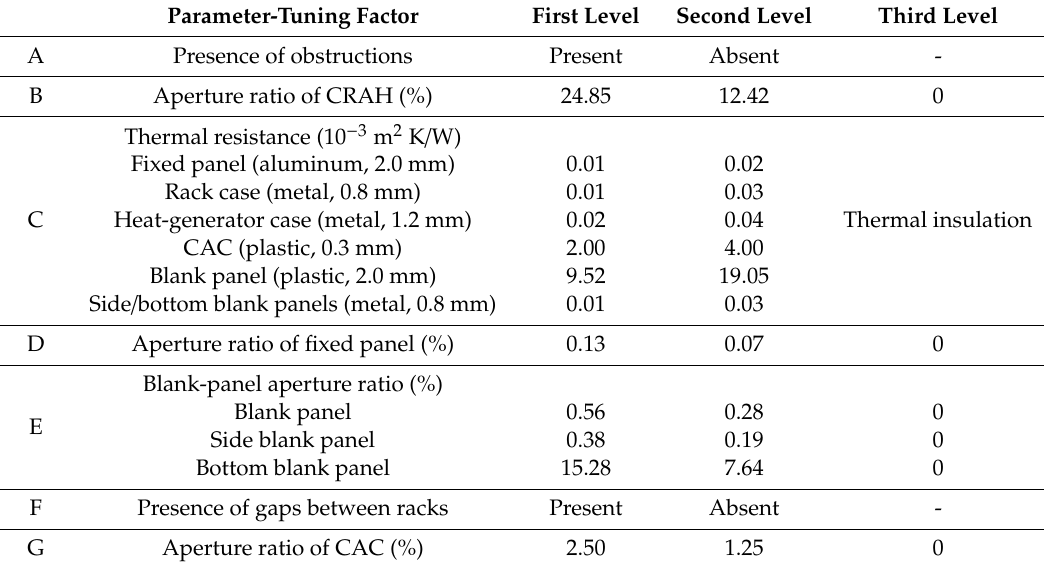
Table 6. Parameter-tuning Table 5. Signal factors and conditions for computational fluid dynamics (CFD) models.